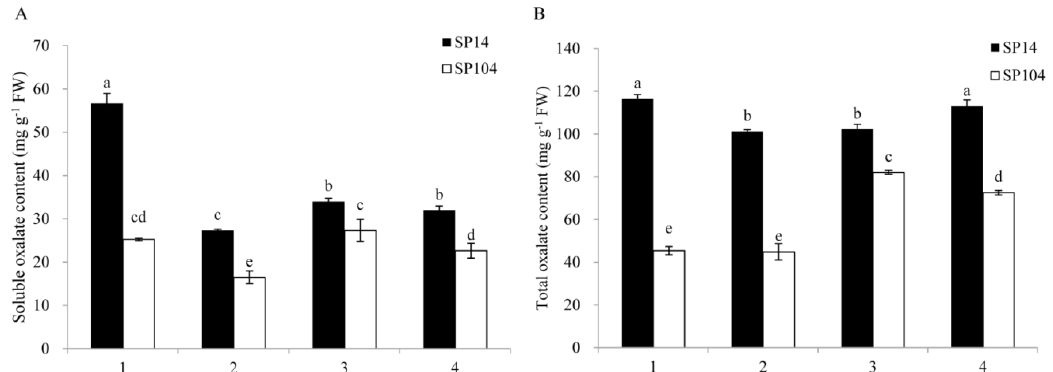
Figure 2. Contents of soluble oxalate ( A ) and total oxalate ( B ) in four parts of spinach. The four parts were (1) mature leaf laminas; (2) mature leaf petioles; (3) young leaf laminas; and (4) young leaf petioles. Error bars represent standard deviation among three independent replicates. Data are means of three replicates ±SD. Different letters (a, b, c, or d) indicate significant differences at P <0.05.